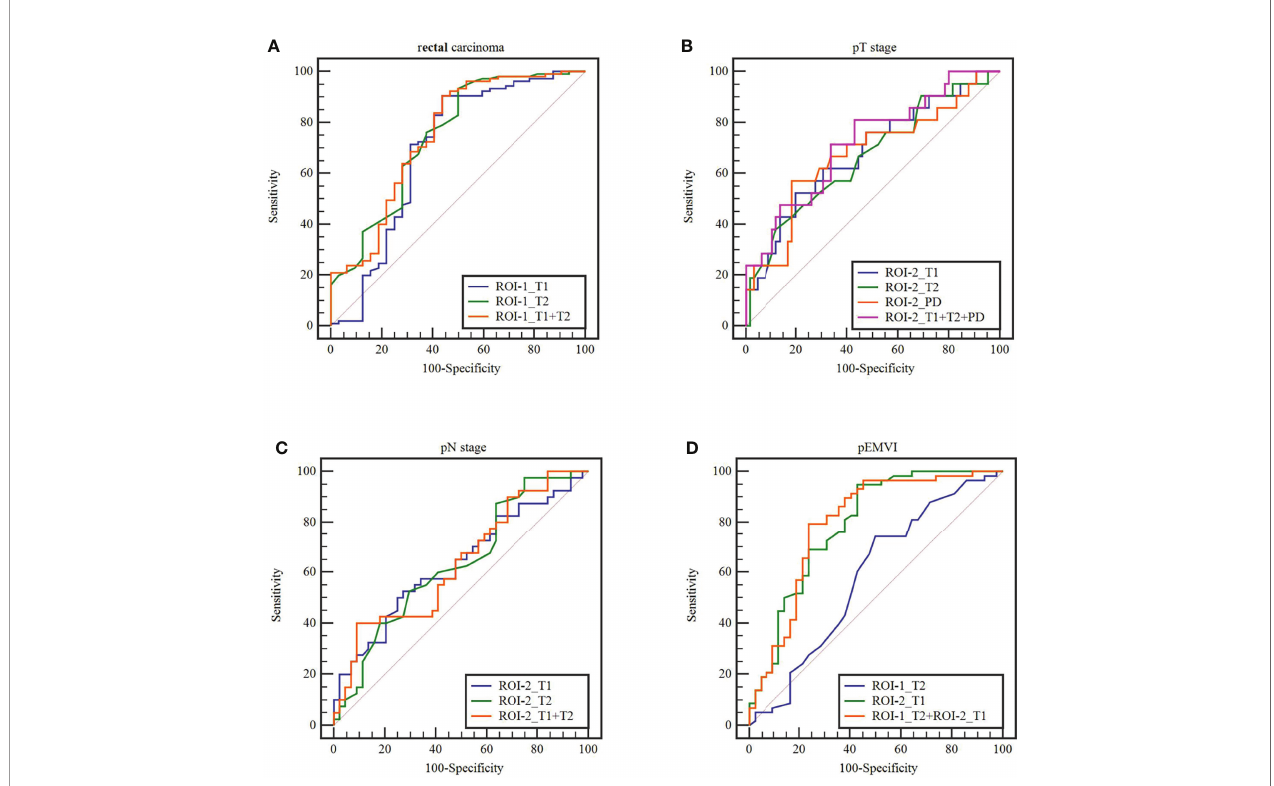
FIGURE 6 | The receiver operating characteristics curves of ROI-1_T1, ROI-1_T2,ROI-2_T1,ROI-2_T2, AND ROI-2_PD values and combined model in terms of (A) rectal carcinoma, (B) T stage, (C) N stage and (D) extramural venous invasion (EMVI).